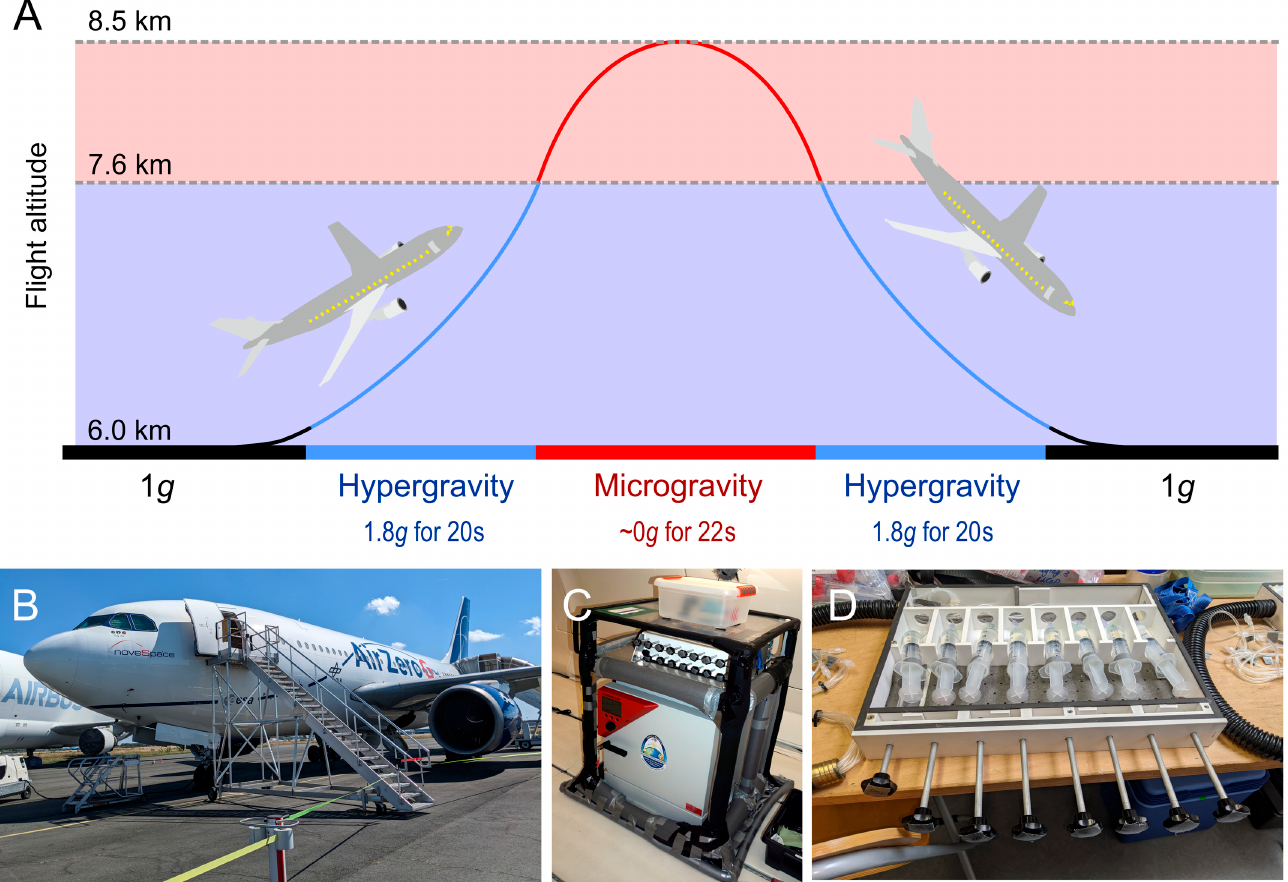
Figure 2. Parabolic flight campaign (PFC). ( A ) Time sequence of a parabola. ( B ) Airbus A310 AirZeroG aircraft from Novespace at the PFC in Bordeaux, France (October 2022). ( C ) The PFC flight rack with an incubator. ( D ) The injection unit of the flight rack during preparation. It is used for fi xation of the cells with RNA later or other fi xatives.